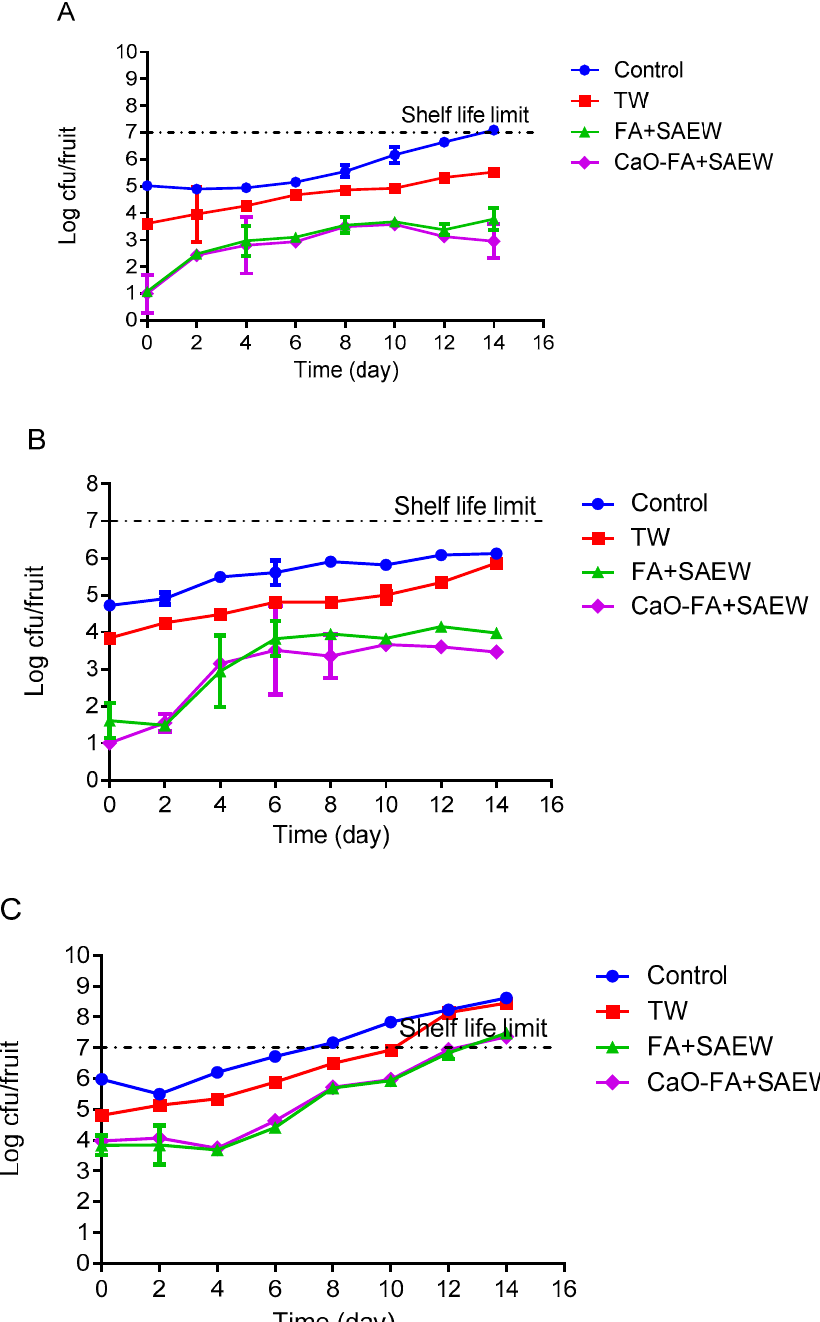
Figure 3. The growth of total aerobic bacteria on fruits during storage at 4 °C after different treatments. TW: Tap water; FA+SAEW: Combination of FA and SAEW treatment; CaO–FA+SAEW: Calcium oxide washing followed by combination of FA+SAEW treatment. Red line represents the end of shelf-life. ( A ) Apple; ( B ) mandarin; ( C ) tomato. Vertical bars represent standard error of the mean ( n = 3).